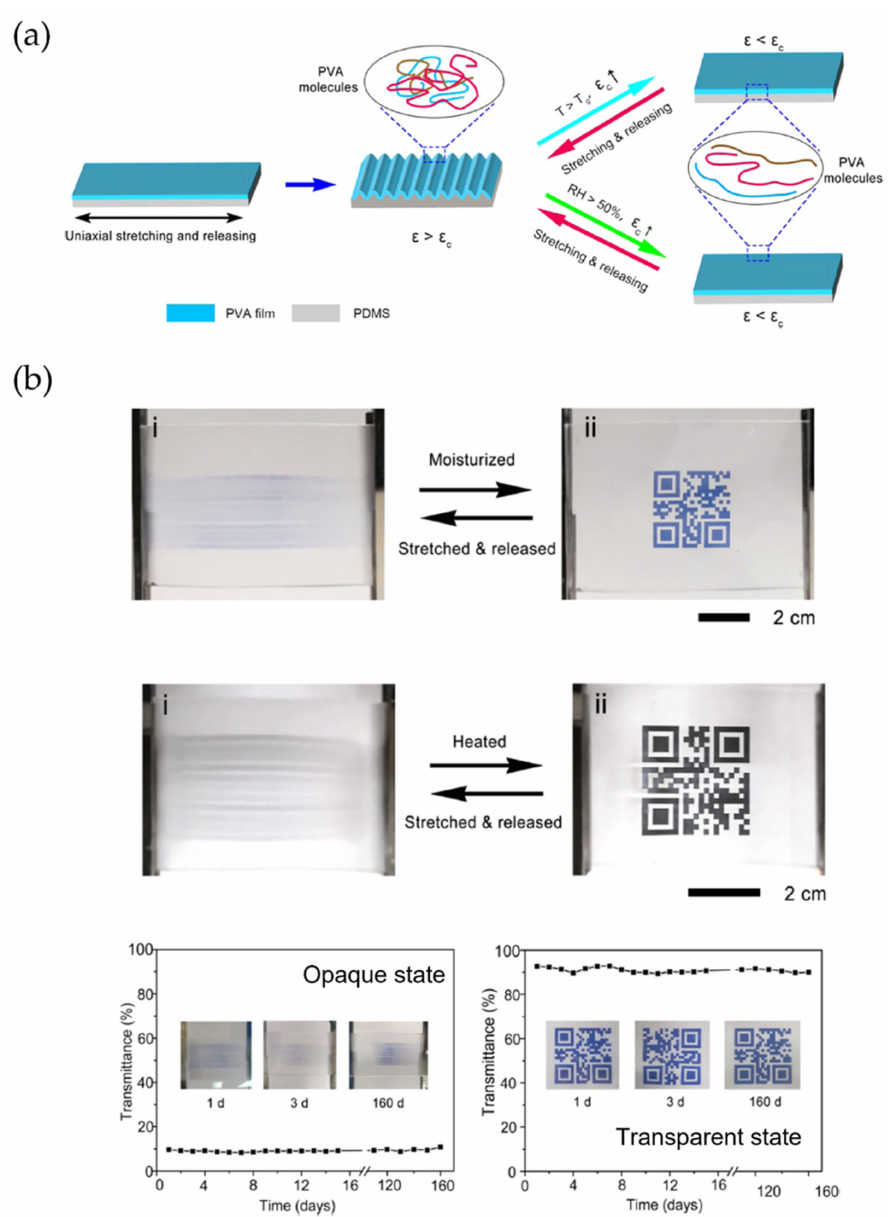
( a ) Schematic illustration showing the fabrication process and reversible wrin- kling/dewrinkling mechanism of moisture and temperature dual-responsive surface wrinkles on the PVDA/PMDS film. ( b ) Dual stimuli-sensitive smart windows. Digital photos of humidity-driven smart windows (top, i: stretched and released, ii: moisturized). Digital photos of temperature-driven smart windows (middle i: stretched and released, ii: heated) and transmittance of smart windows